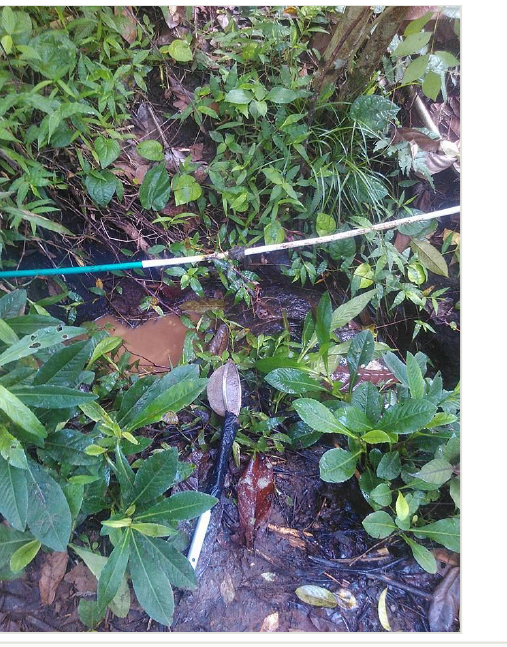
Figure 31. Collecting site